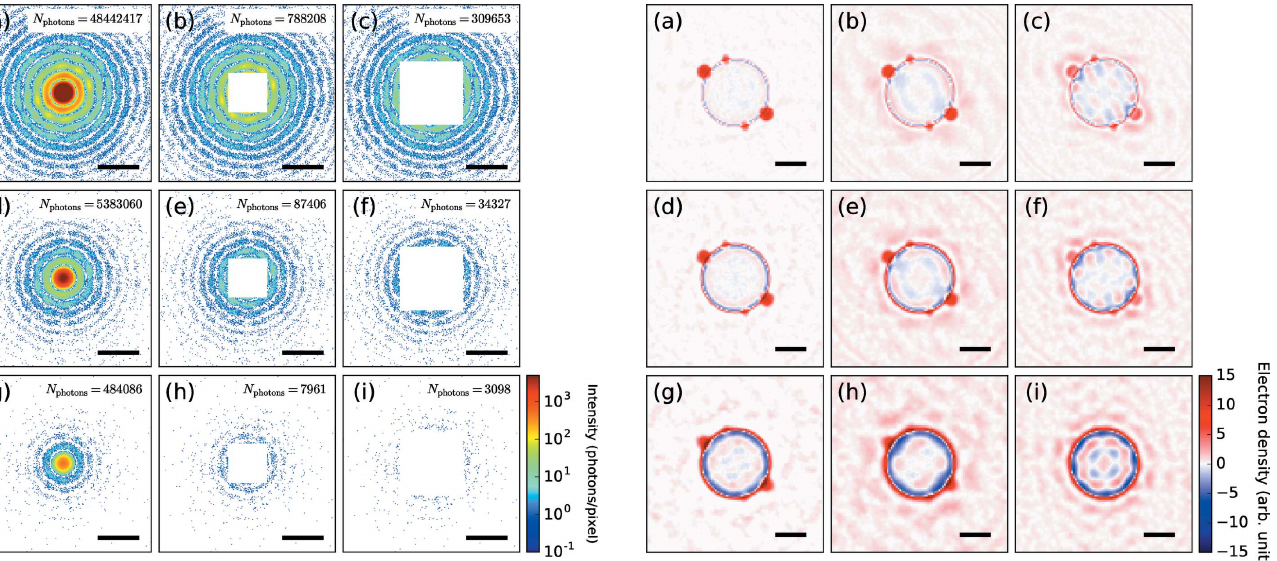
Figure 3 Diffraction patterns simulated from the electron density shown in Fig. 2( a ). The top row represents the highest incident XFEL fluence case and the fluence is reduced as it moves to the bottom. The first column shows the diffraction patterns without missing regions and the missing region becomes larger as it moves to the right. The current experimental condition corresponds to the middle one ( e ). The scale bars are 0.1 nm (cid:4) 1 .